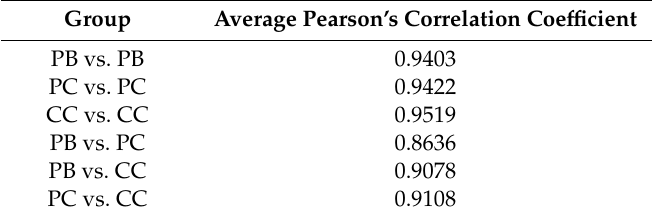
Table 1. Average Pearson’s correlation coefficients for comparisons of intragroup and intergroup